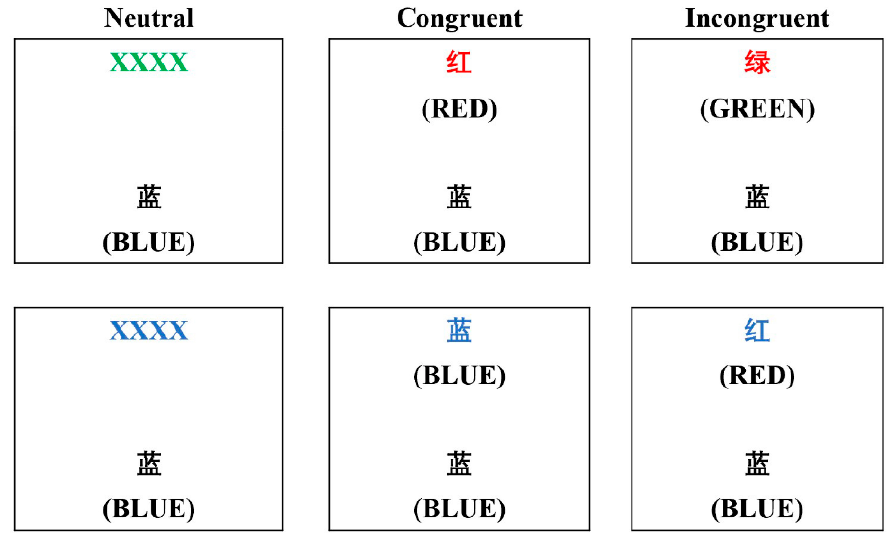
Figure 2. Instances of single trials for the neutral, congruent, and incongruent conditions of the color–word matching Stroop task.